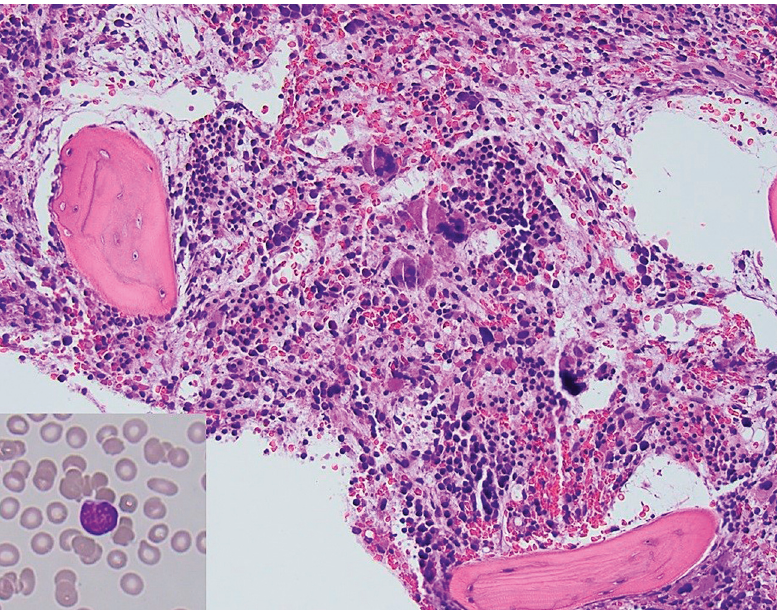
Figure 1: Hematoxylin and Eosin (H & E) stained bone marrow biopsy section showing hypercellular marrow with myeloid hypoplasia, erythroid hyperplasia, and increased atypical megakaryocytes (x200). An enclosed picture shows the morphology of the immature cells on a Wright-Giemsa-stained bone marrow aspirate smear